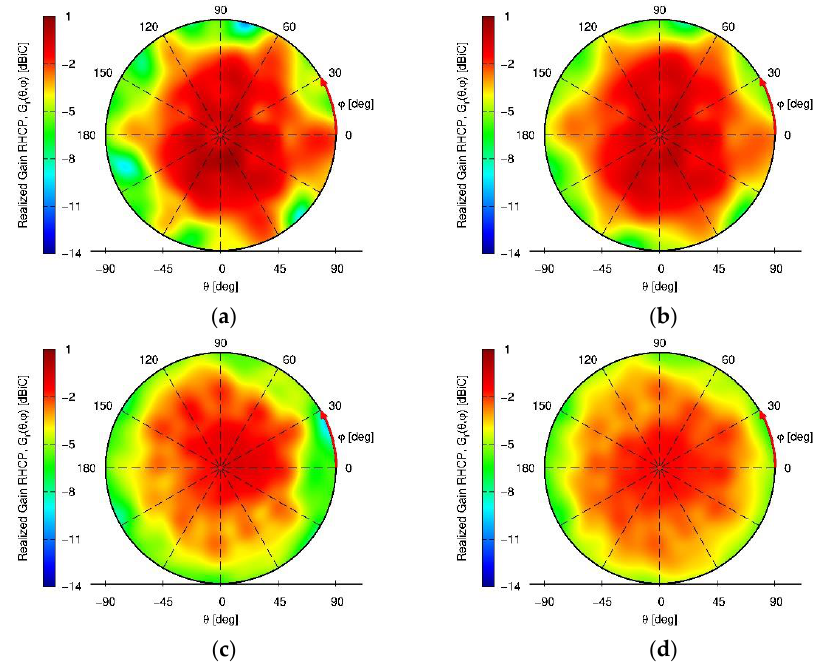
Figure 11. Measured RHCP and LHCP realized gain patterns of the miniaturized GNSS array with and without vertical choke rings on a hex-rotor UAV for an installation height of 110 mm. ( a ) L5/E5a, h = 110 mm wo. vertical choke; ( b ) L5/E5a, h = 110 mm w. vertical choke; ( c ) L1/E1, h = 110 mm wo. vertical choke; ( d ) L1/E1, h = 110 mm w. vertical choke.